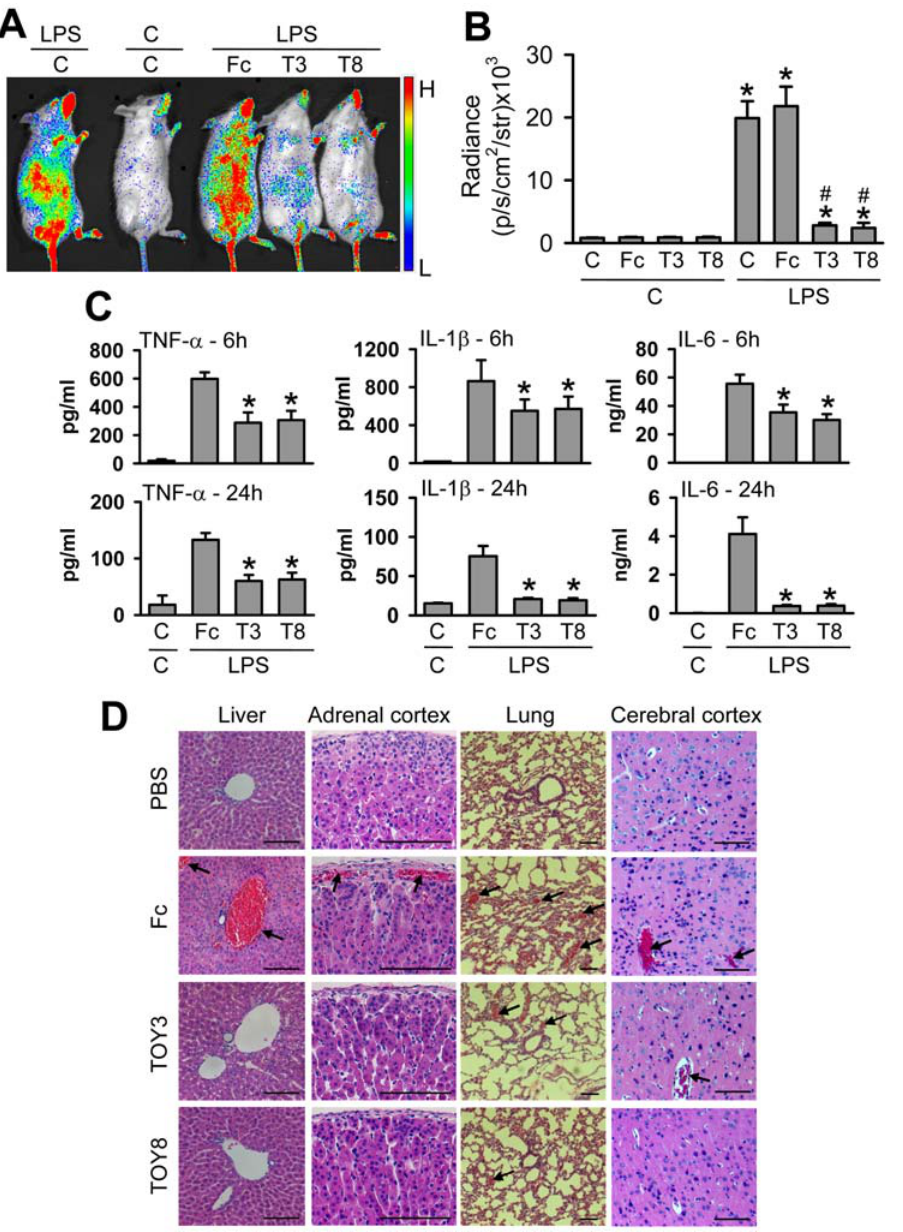
Figure 8. TOY attenuates LPS-induced NF- k B activation, secretion of proinflammatory cytokines, and thrombus formation. ( A and B ) NF k B-RE-luc mice were injected intraperitoneally with control PBS (C) or 20 mg/kg of Fc, TOY3 (T3), or TOY8 (T8) at 1 hr after intraperitoneal administration of C or LPS (1 mg/kg). At 24 hr later, the luminescence signals from the whole body were examined by IVIS imaging ( A ). The luminescence was quantified and expressed as radiance (photon/sec/cm 2 /steradian) ( B ). Bars represent means 6 S.D. ( n =3–4). *, P , 0.05 versus C + C; # , P , 0.05 versus C + LPS or Fc + LPS. ( C and D ) Wild-type mice were injected intraperitoneally with C or 20 mg/kg of Fc, T3, or T8 at 1 hr after intraperitoneal administration of LPS (7.5 mg/kg) or C. At 6 and 24 hr later, plasma levels of TNF- a , IL-1 b , and IL-6 were measured ( C ). Bars represent means 6 S.D. ( n =4–5). *, P , 0.05 versus Fc + LPS. At 24 hr after treatment, the mice were anesthetized, and samples of liver, adrenal gland, lung, and brain were H&E stained ( D ). Arrows indicate thrombi in the blood vessels. Scale bars, 100 m